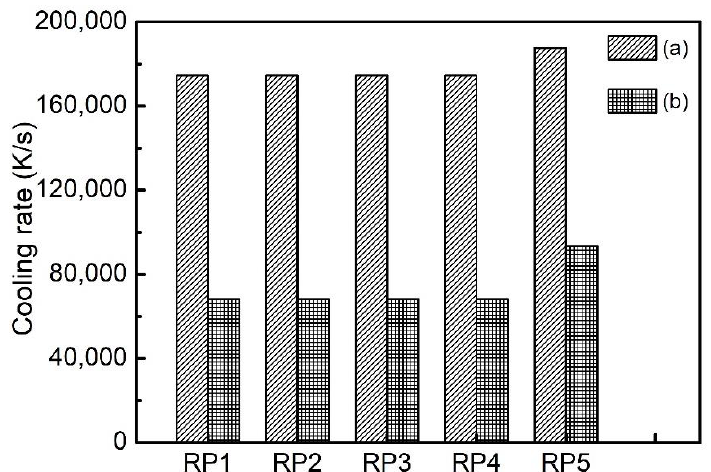
Figure 7. Maximum cooling rate at the five radial sampling points: ( a ) at the end of the melting process of the layer in question, ( b ) resulting from the thermal processes of subsequent layers.